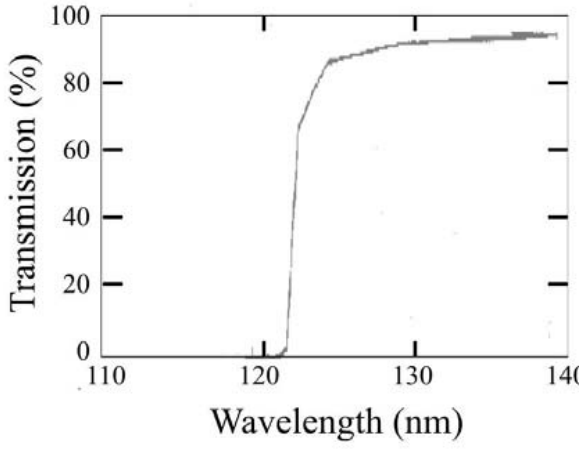
Fig. 3. Transmission curve for 0.5mm thick CaF 2 filter. Data from Fig. 3 . Transmission curve for 0.5 mm thick CaF Laufer et al.